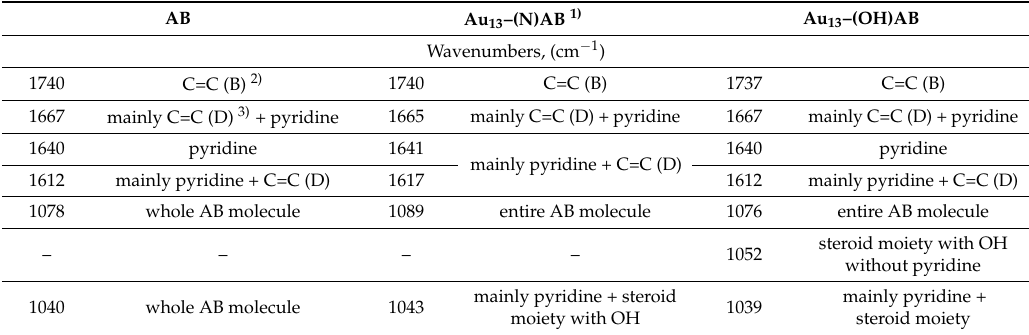
Table 3. A description of characteristic bands from the theoretical spectra of AB, Au 13 –(N)AB, and Au 13